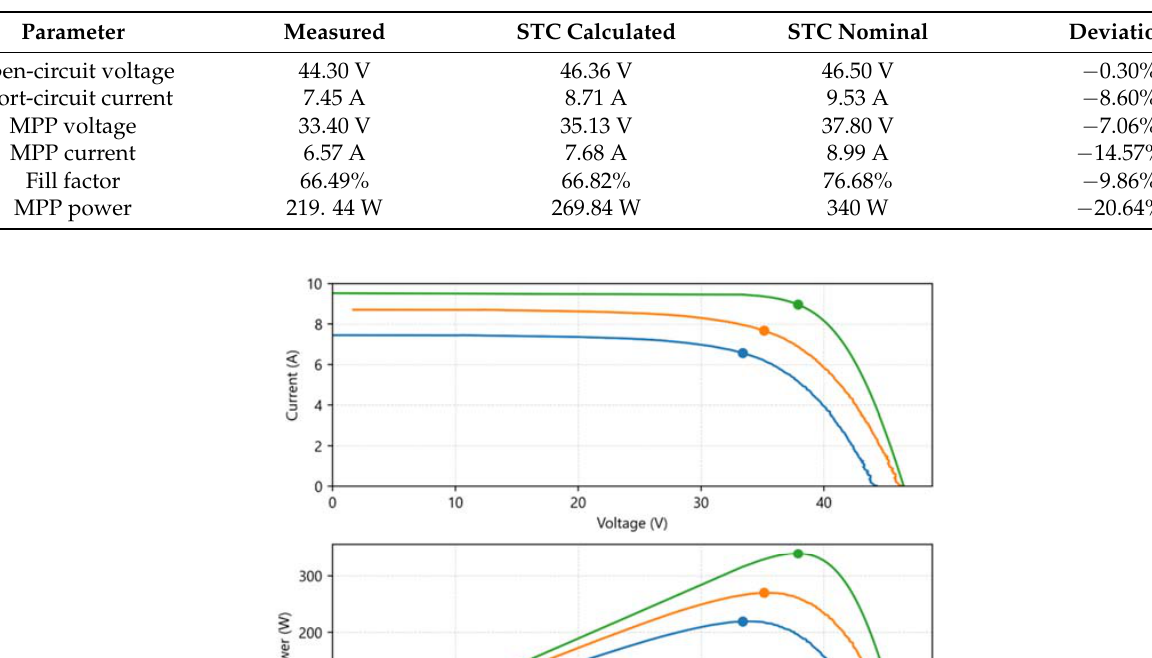
Figure 15. I ‐ V and P ‐ V curves of the PV module 1 (washed). The numerical and graphical results of the I ‐ V curve measurements of the second PV module are given in Table 11 and Figure 16. Table 11. PV module 1 (washed) I ‐ V curve test results.